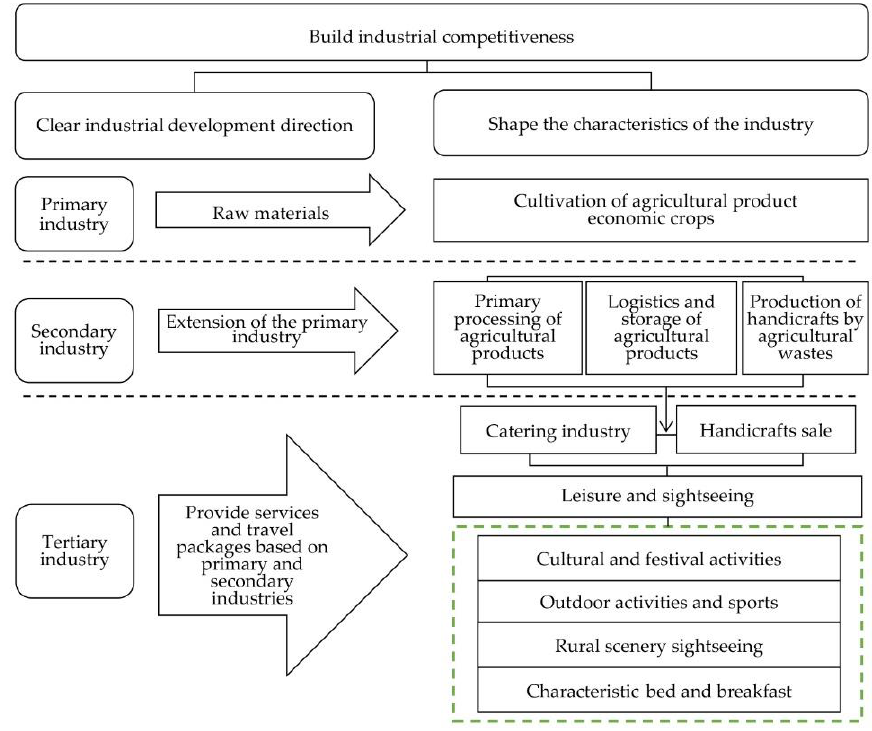
Figure 6. Schematic diagram of the industrial chain for building industrial competitiveness.